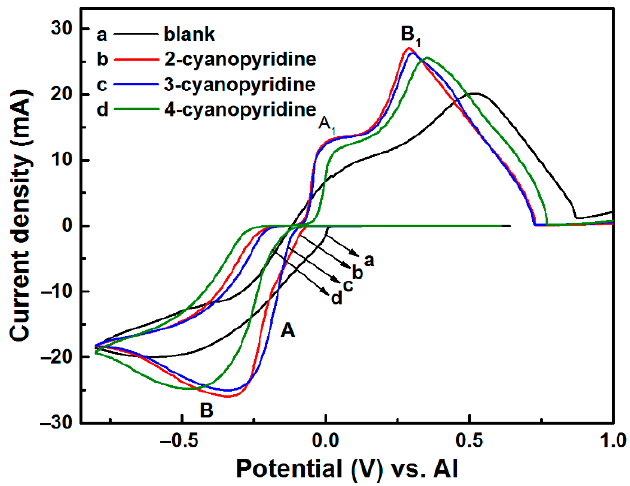
Figure 2. Cyclic voltammogram recorded on the Cu electrode in AlCl 3 -EMIC ionic liquids containing ( a ) no and 6 mM of ( b ) 2-cyanopyridine, ( c ) 3-cyanopyridine, and ( d ) 4-cyanopyridine at 303